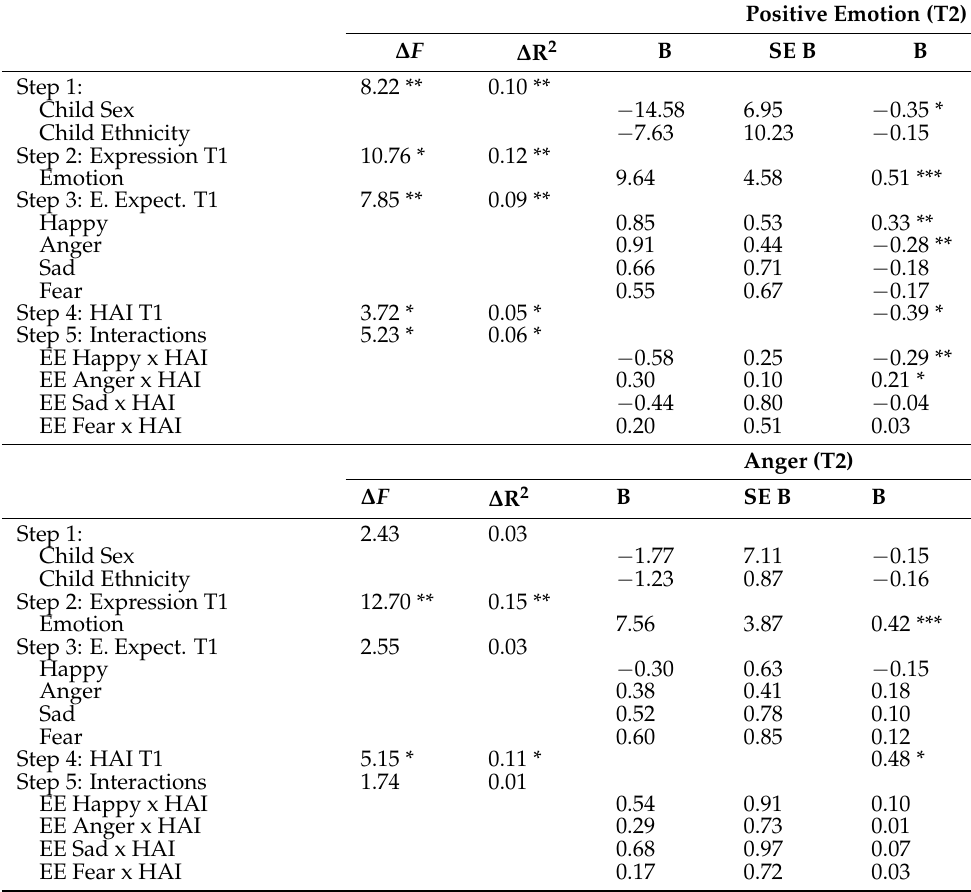
Table 5. Adolescent emotional expectancies and hostile attributions as predictors of adolescents’ expressions of emotion with